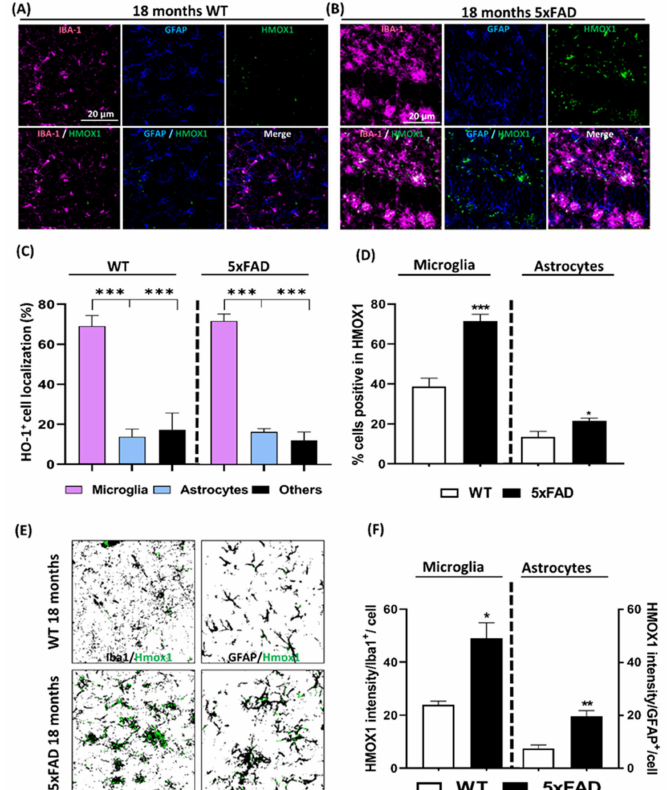
Figure 4. Microglial Hmox1 RNA expression is increased in 18-month-old 5xFAD mice. Representative images of RNAscope immunofluorescence of Iba1 + microglia (magenta), GFAP + astrocytes (blue) and HO-1 (green) in 18 months WT ( A ) and 5xFAD animals ( B ). ( C ) Localization of Hmox1 positive signal in percentage in either microglia, astrocytes or other CNS cell types. ( D ) Percentage of total microglia or astrocytes expressing Hmox1 in WT (white column) and 5xFAD mice (black column). There was a significant increase in both microglia and astrocytes expressing Hmox1 in the 5xFAD in comparison to WT mice. However, around 80% of total microglia in 5xFAD animals express Hmox1 while just around 20% of astrocytes express it. ( E ) Representative composite of the percentage of microglia and astrocytes (black) positive in Hmox1 staining (green) ( F ) Hmox1 RNA expression, measured as mean intensity, increases in the 18-month-old 5xFAD microglial cells and astrocytes compared to the WT controls, although Hmox1 mean intensity was higher in microglia than in astrocytes. Significant di ff erences were considered when: *** p < 0.001 compared to the percentage of HMOX1 + staining in microglia ( C ) and * p < 0.03, ** p < 0.002 and *** p < 0.001 compared to age-matched WT mice ( D , F ). Data represent mean ± S.E.M. ( N =